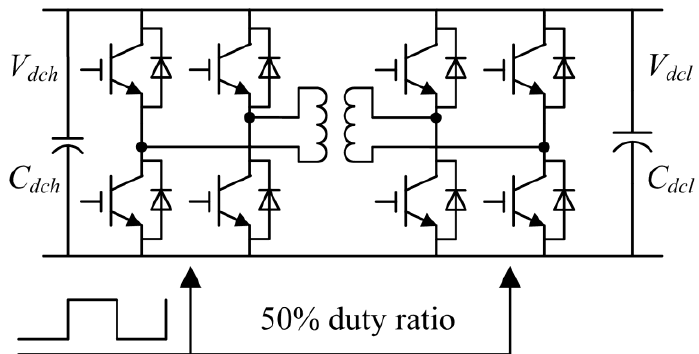
Figure 5. Control strategy of the isolation stage